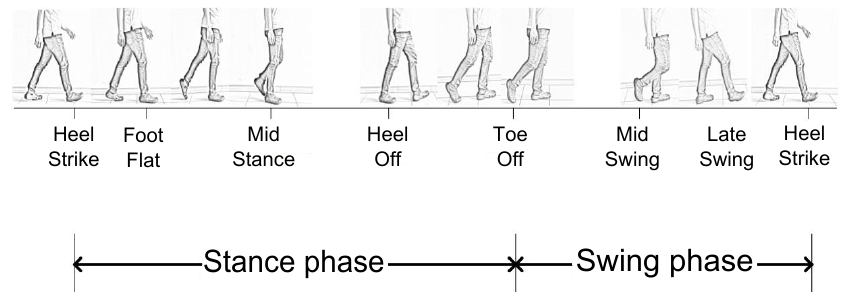
Figure 1. Analyzing phases of the gait